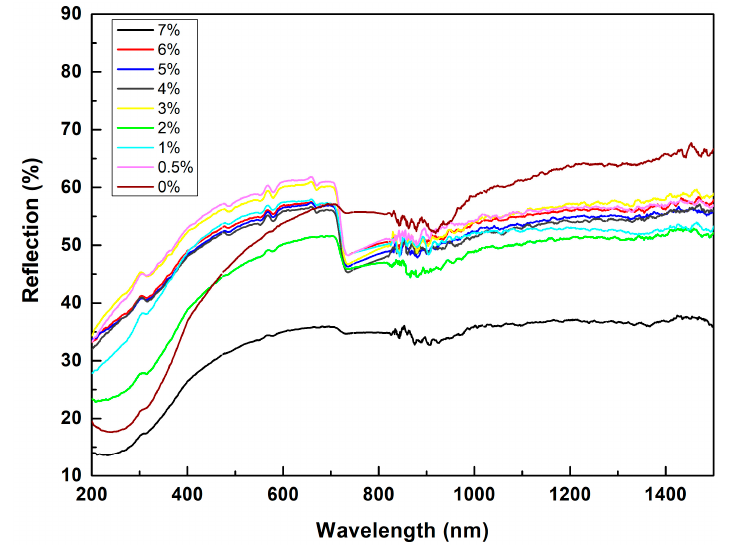
Figure 7. The UV-Vis analysis results of the SiC/PVB composite powders with different PVB contents.